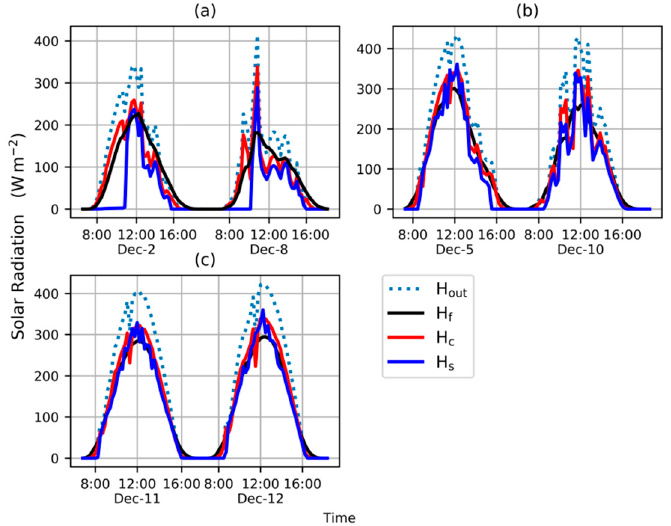
Figure 3. Solar radiation under different weather conditions ( a ) overcast ( b ) partly cloudy ( c )